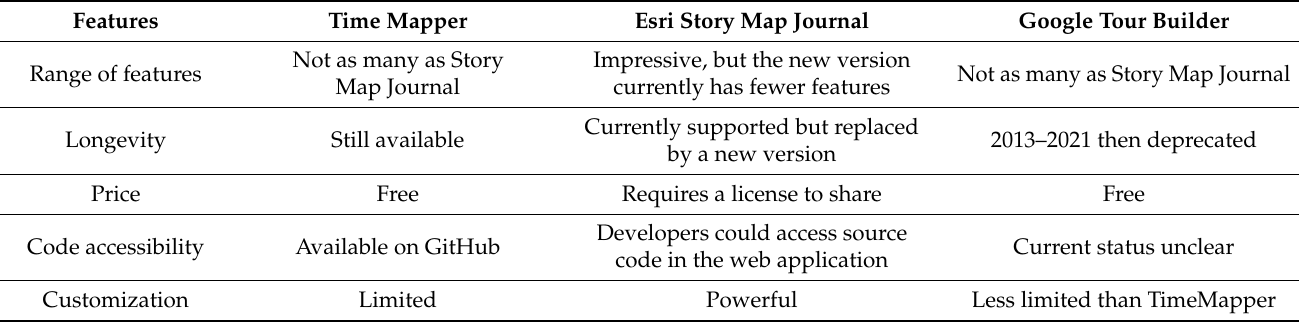
Table 1. Comparison of story mapping